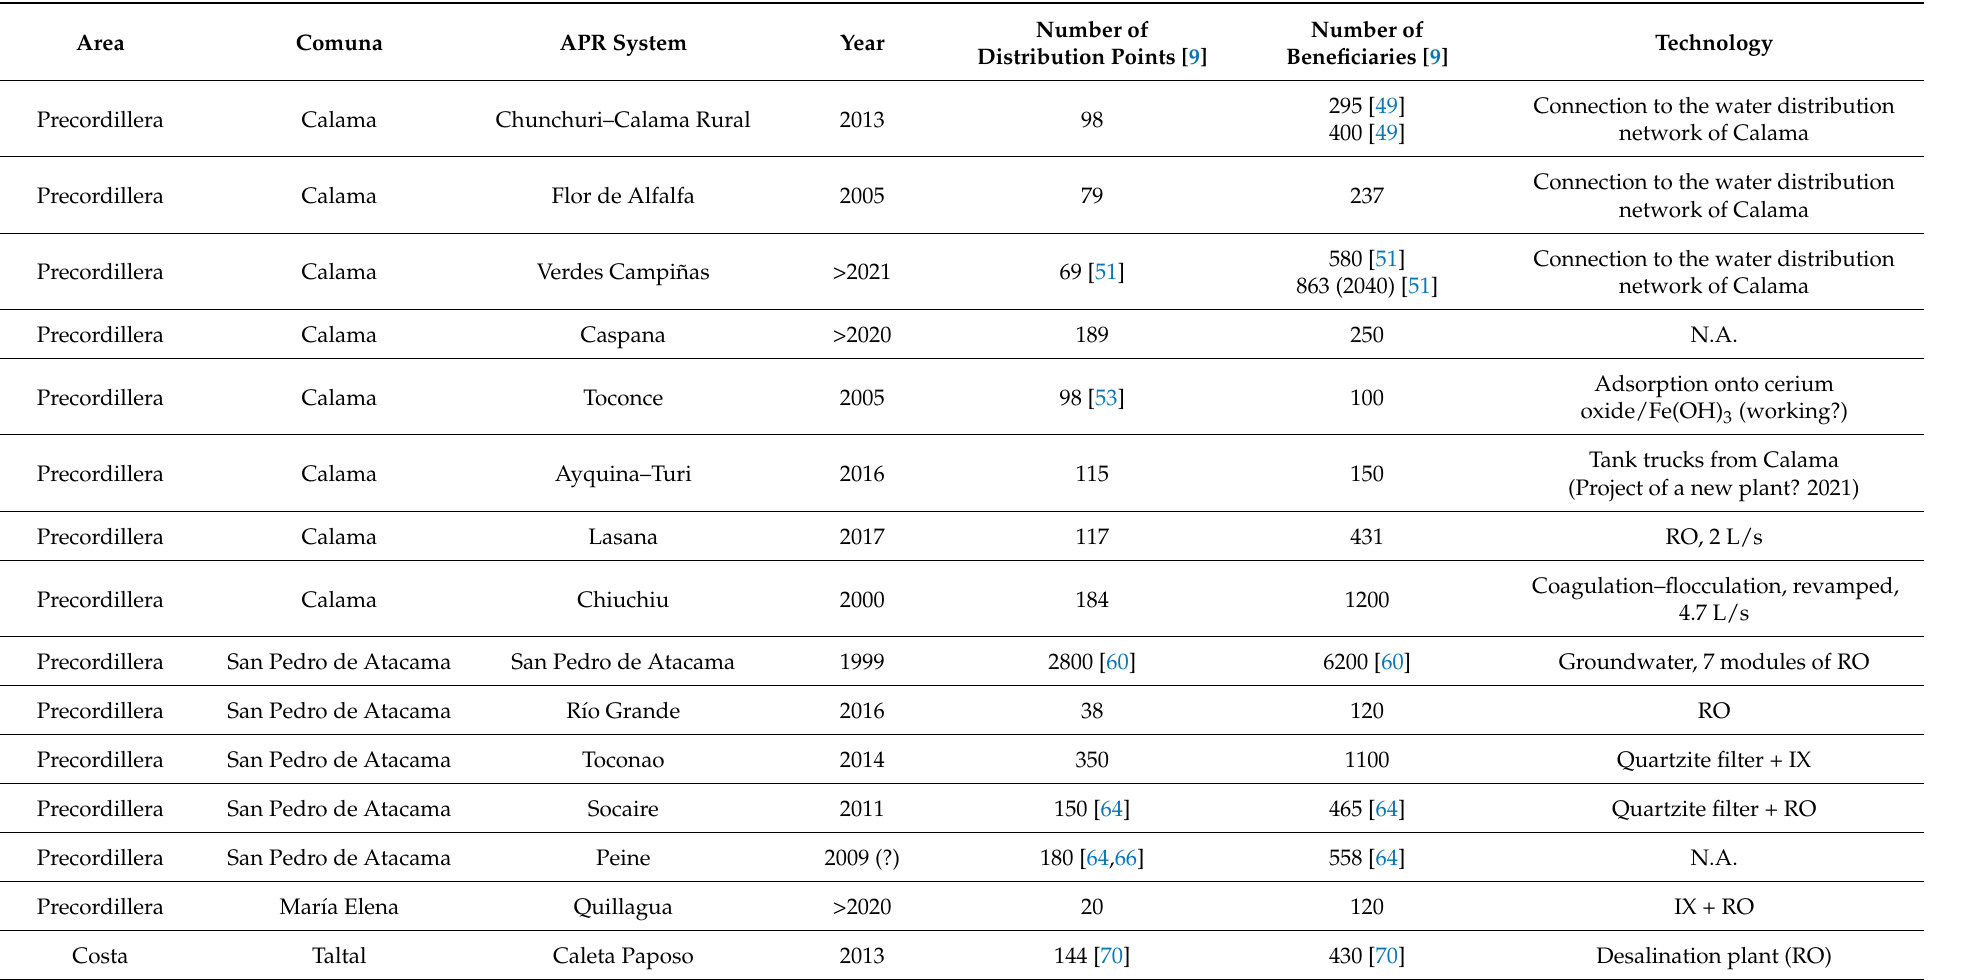
Table 2. APR systems in the region of Antofagasta with their main characteristics (number of distribution points and beneficiaries and employed